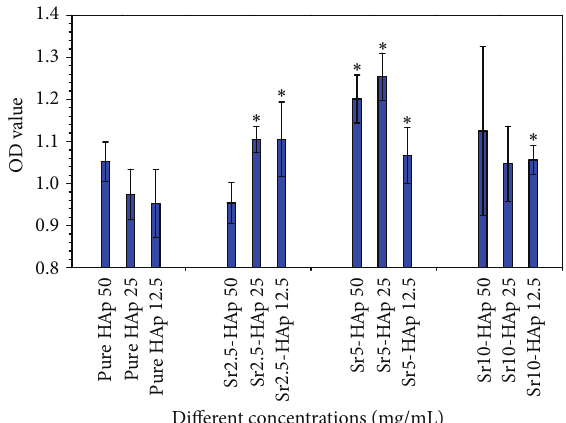
Figure 3: The FTIR spectra of the obtained HAp and Sr-substituted HAp whiskers.